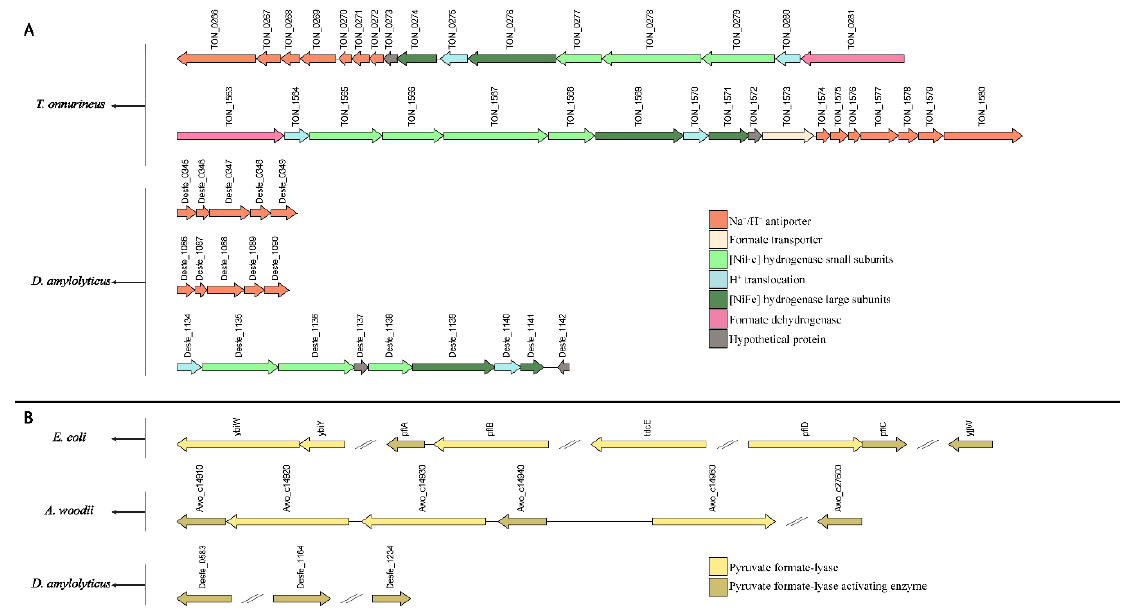
Figure 5. Comparison of genetic organization of ( A ) the fdh complex subunits in T. onnurineus , and ( B ) the pyruvate formate lyase (PFL) complex subunits in E. coli and A. woodii to the genetic organisation in D. amylolyticus .